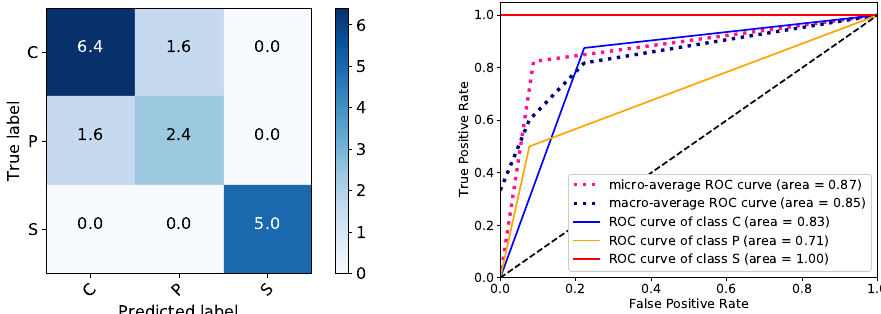
ROC curve of class C (area = 0.83) ROC curve of class P (area = 0.71) ROC curve of class S (area = 1.00)